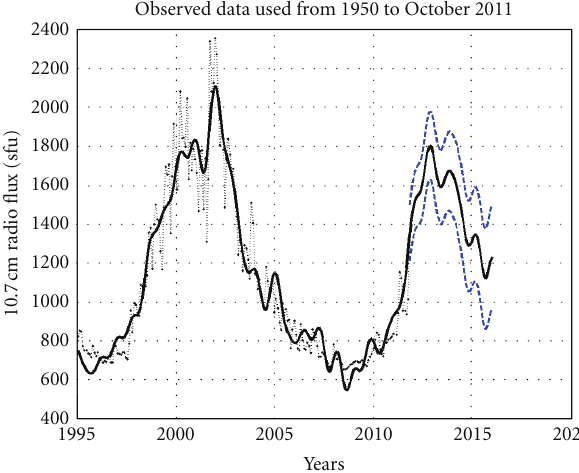
Figure 5: SC24 shape prediction of monthly mean indices for 10.7cm radio flux variation. Dotted line demonstrates the real data. Dashes show the one sigma intervals. Solid is the modeled curve.